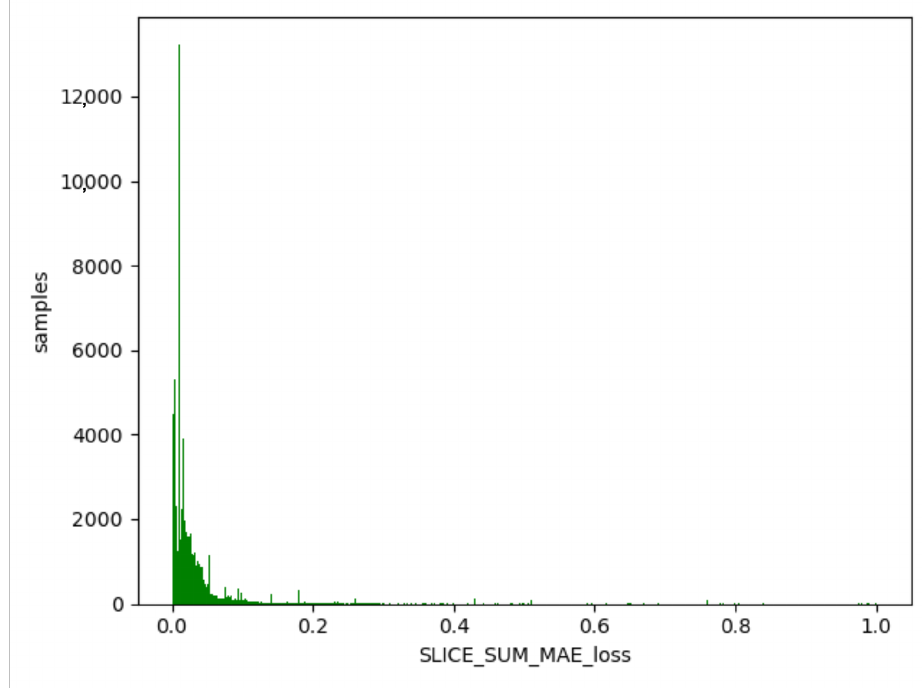
Figure 13. UNSW-NB15 training set. Green indicates normal data.